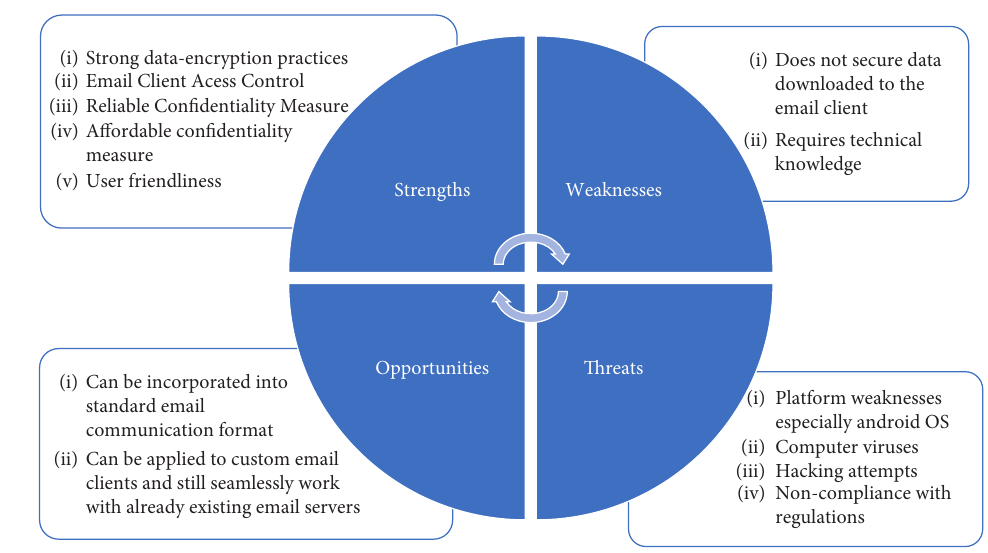
Figure 6: SWOT analysis of the designed email wipe algorithm. Table 4: Analysis of the developed algorithm against existing techniques based on Android platform.